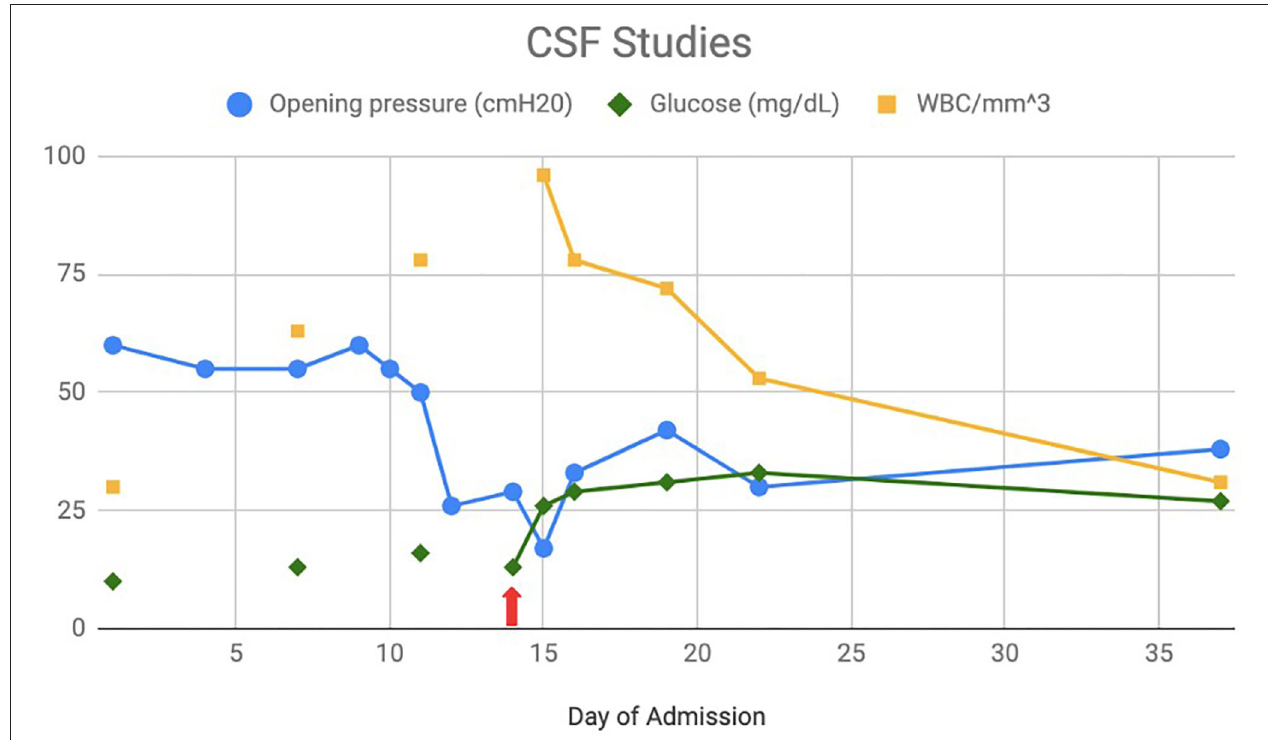
FIGURE 1 | Cerebrospinal fluid (CSF) studies: CSF opening pressure, glucose, and WBC count over the course of initial hospitalization with initiation of steroids on day 13 (red arrow).